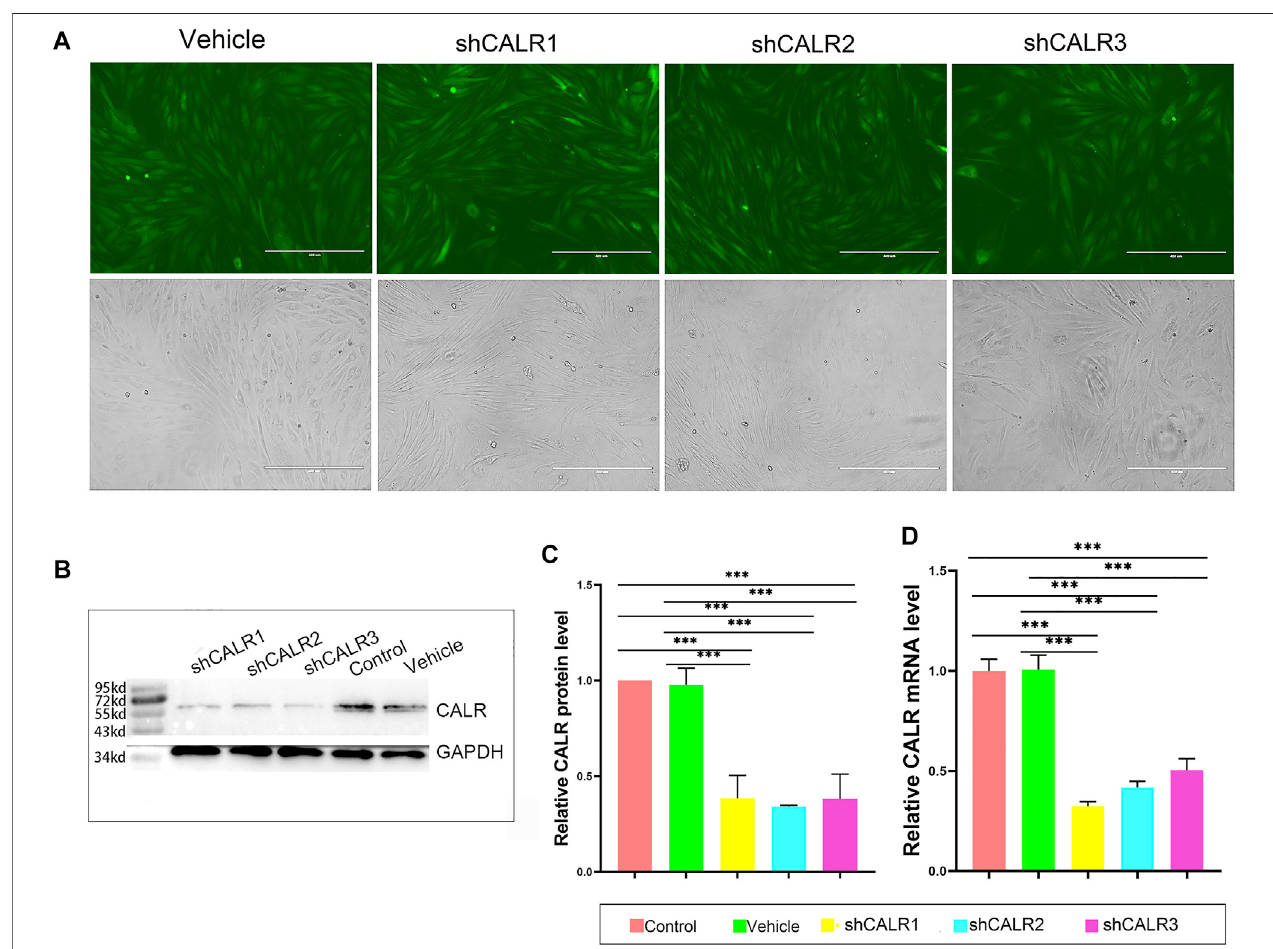
FIGURE 7 | Effects of RNAi on the CALR expression in the AcPP cells. (A) GFP expression pro fi les 48 h after lentiviral infection; it is to be noted that fl uorescence wasclearlyobservableinbothshRNA-CALRinfectedandemptyvector-infected(vehicle)cells;Scalebars=400 µm. (B) Expressionpro fi lesofCALRproteinintheAcPP cells after transfection with shCALR1, shCALR2, shCALR3, or empty vector (vehicle) using Western blot analysis. (C) Relative expression levels of CALR protein in the AcPPcells;itistobenotedthatshCALR1,shCALR2,orshCALR3signi fi cantlydownregulatedCALRexpression. (D) RelativeexpressionlevelsofCALRmRNA;itis to be noted that the results are consistent with those of Western blot analysis, and the most effective one is shCALR1. * p < 0.05 and *** p < 0.001.